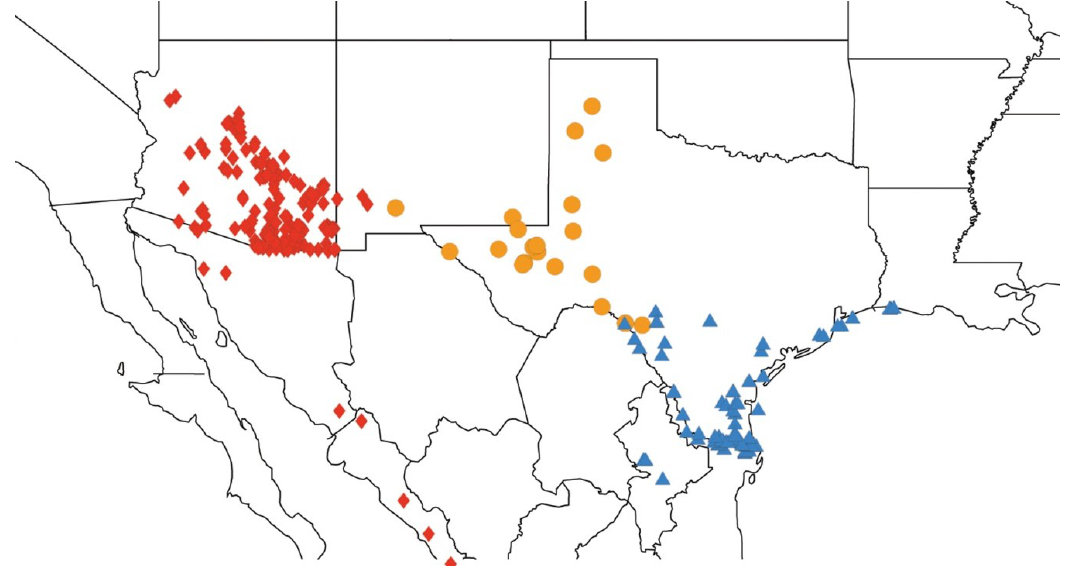
Figure 5. Distribution of Dicerprocta aurantiaca (gold circles), D. delicata (blue triangles) and D. semicincta (red diamonds).